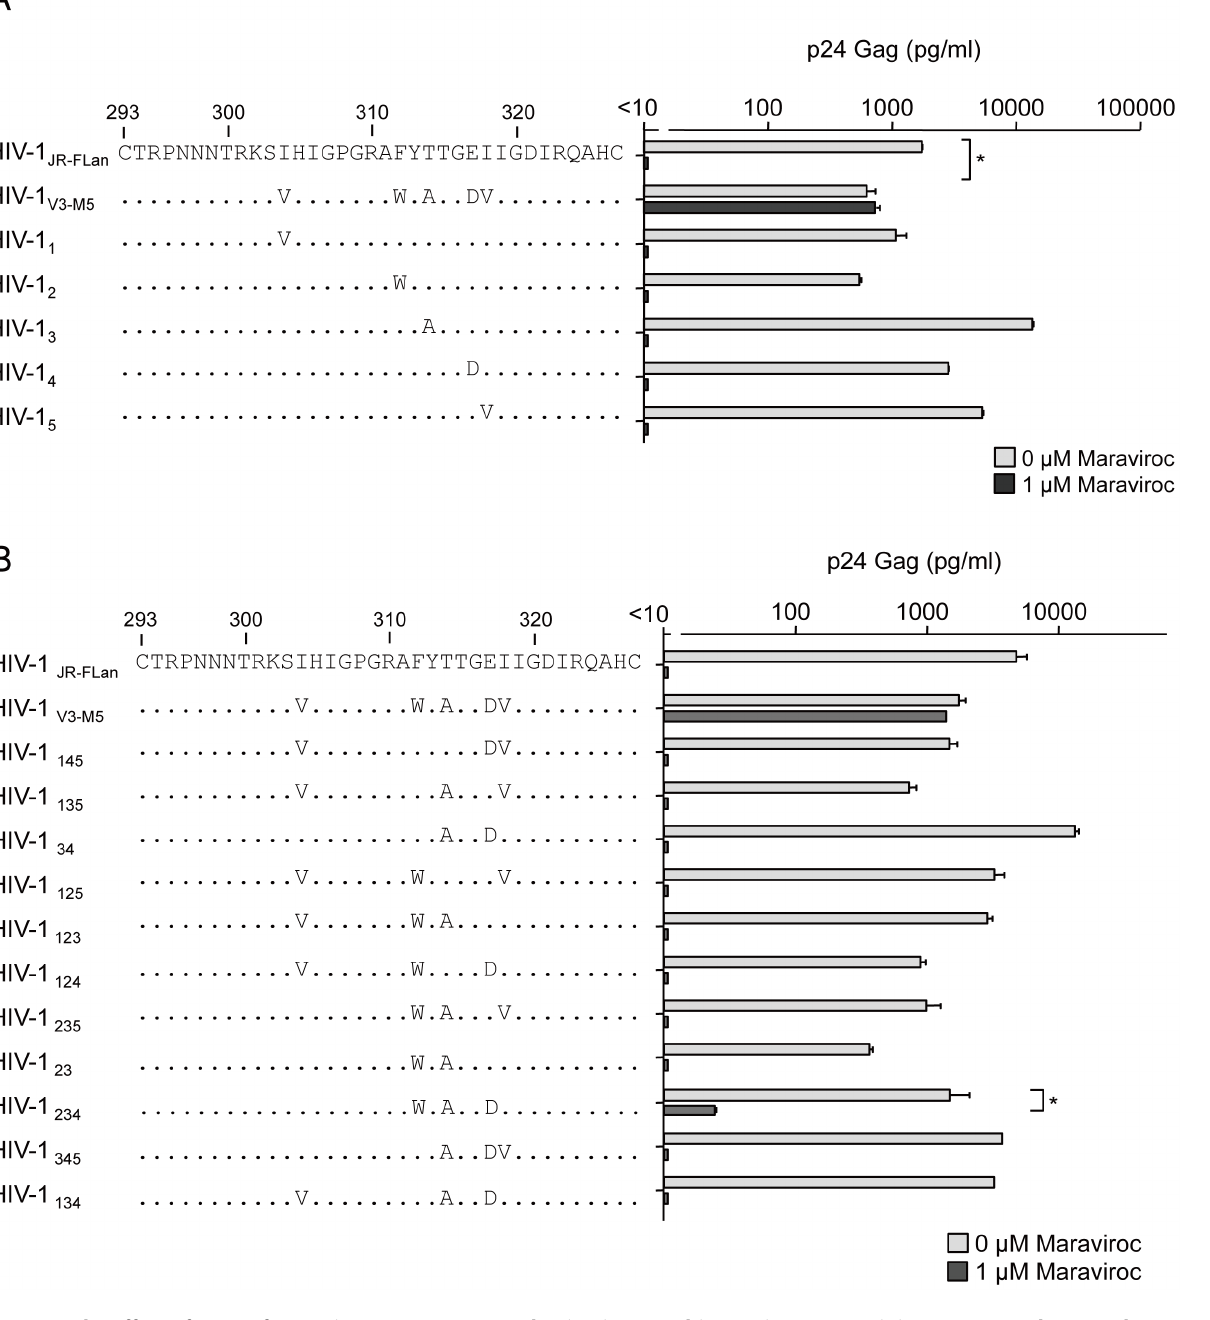
Figure 2. The effect of 1 m M of maraviroc on p24 Gag production in recombinant viruses containing one (A) and two or three (B) of the five amino acid substitutions. PM1/CCR5 cells (1 6 10 5 ) were infected with 10 ng p24 Gag for 3 h in the presence or absence of 1 m M maraviroc. On day 6 after infection, the amount of Gag in the supernatant was measured using HIV-1 p24 ELISA. The analysis was repeated three times; the error bars represent the S.D. of three replicates from one representative experiment. **, p , 0.01. Statistical significant difference was calculated by t test.